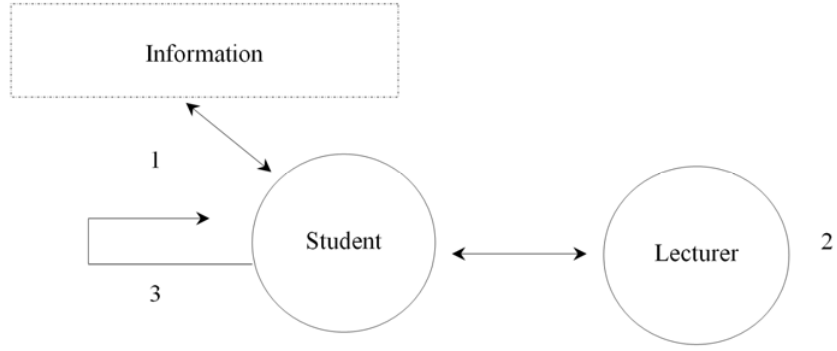
Fig. 1. Main types of ILS interaction